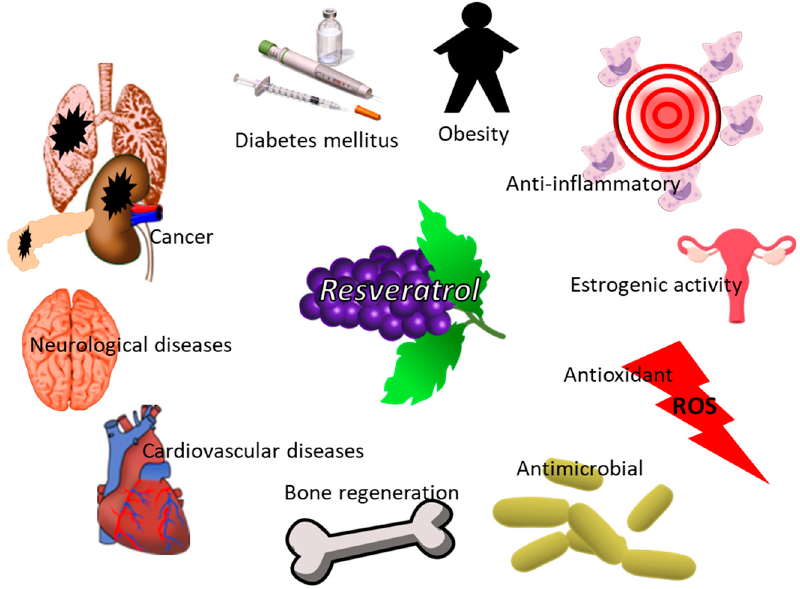
Figure 4. Biological activity of RSV for human wellness.